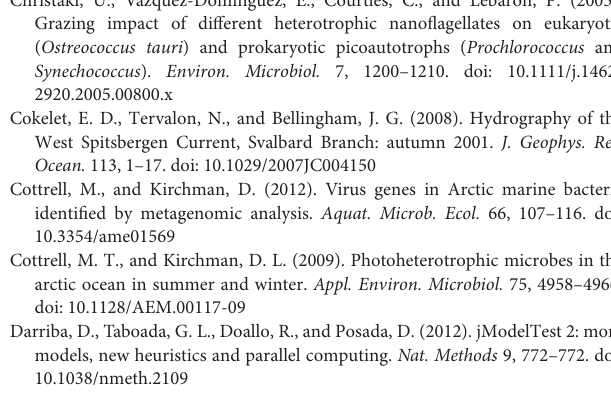
Table S2 | Sequence ID of the members of each Operational Taxonomical Unit (OTU) defined for petB at 97% nucleotide sequence